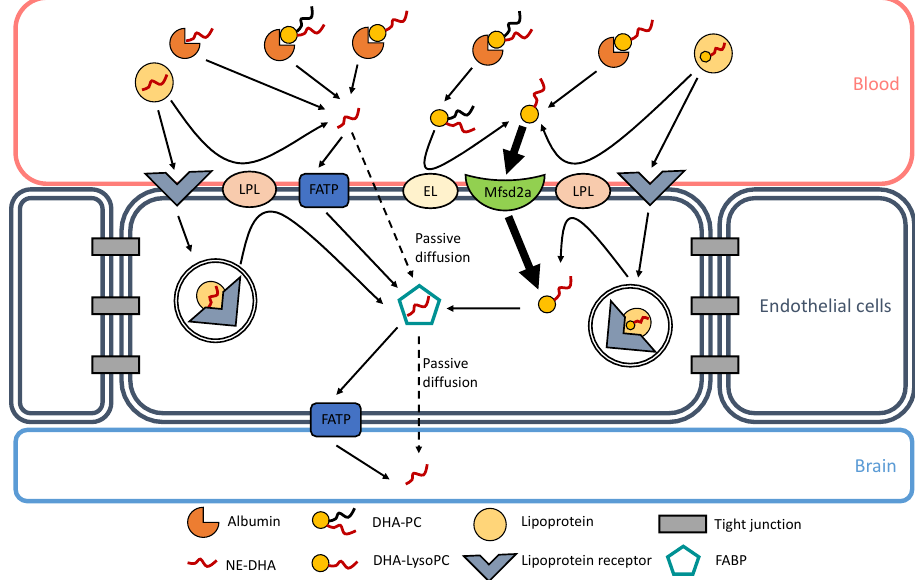
Figure 1. Docosahexaenoic acid (DHA) transport through the blood – brain barrier (BBB). Currently known mechanisms of DHA transport are represented in this figure. In blood, albumin can bind non-esterified DHA (NE-DHA), DHA-containing lysophosphatidylcholine (DHA-LysoPC), and DHA-containing phosphatidylcholine (DHA-PC). NE-DHA is released from albumin in the vicinity of endothelial cell membranes and is incorporated into the endothelium by passive diffusion or transportation through fatty acid transport proteins (FATP). DHA-LysoPC is also released from albumin and can be actively transported into the endothelium through the symport major facilitator superfamily domain-containing protein 2A (Mfsd2a). DHA-PC can also be released from albumin and can generate DHA-LysoP C through the action of an endothelial lipase (EL), as shown by Chen and Subbaiah [51]. Lipoproteins are other carriers of NE-DHA and DHA-LysoPC. They can release NE-DHA and DHA-LysoPC through the action of lipoprotein lipases (LPL). Lipoproteins can also bind to their receptors and go through transcystosis. Inside endothelial cells, lipoproteins can be hydrolyzed and can release either NE-DHA or DHA-LysoPC. In the endothelium, NE-DHA is bound to fatty acid binding proteins (FABP) for it to cross the intercellular space to reach brain cells. NE-DHA can either diffuse passively through the endothelial-brain barrier or be transported through FATP.